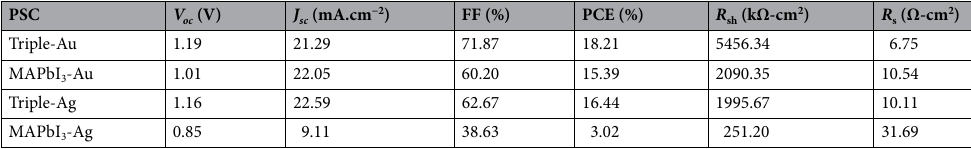
Table 1. Optimized photovoltaic parameters of n-i-p PSCs based on MAPbI 3 and triple cation as absorbers contacted with Au and Ag collector